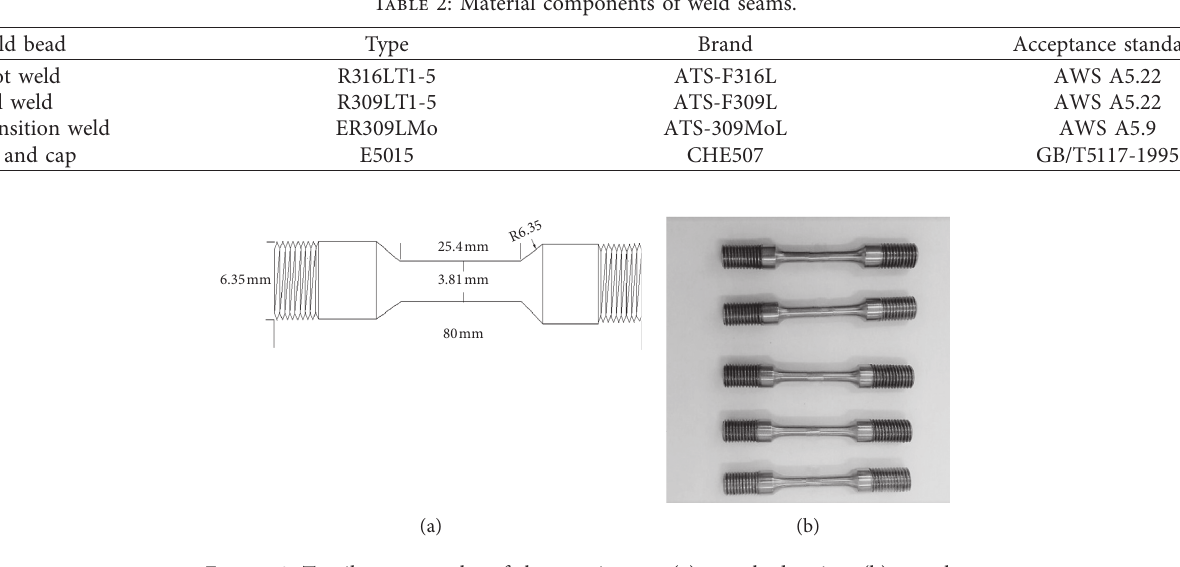
Figure 2: Tensile test samples of slow-strain-rate: (a) sample drawing; (b) Table 3: Ion concentration of reagents and used drugs.